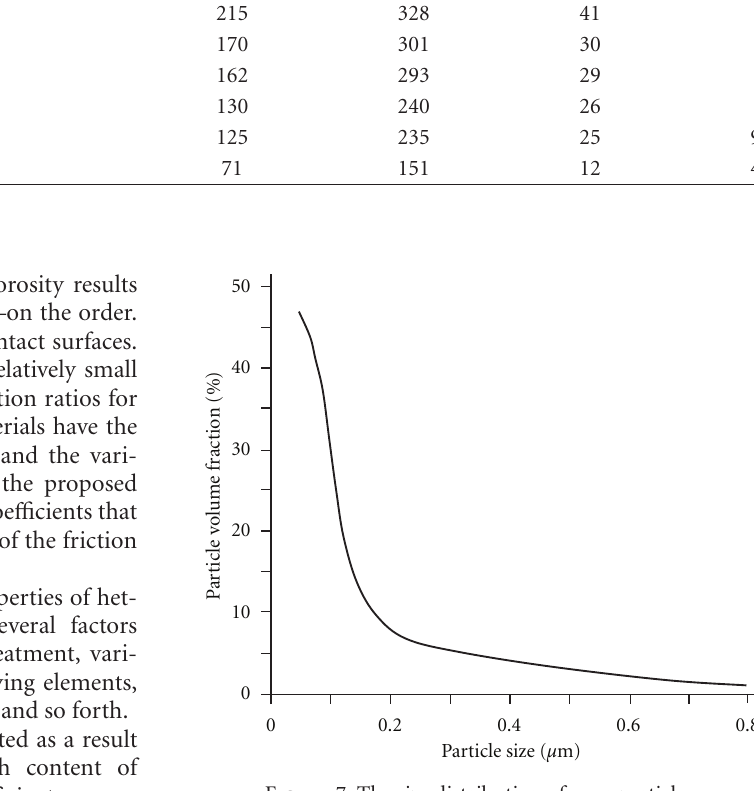
Figure 7: The size distribution of wear